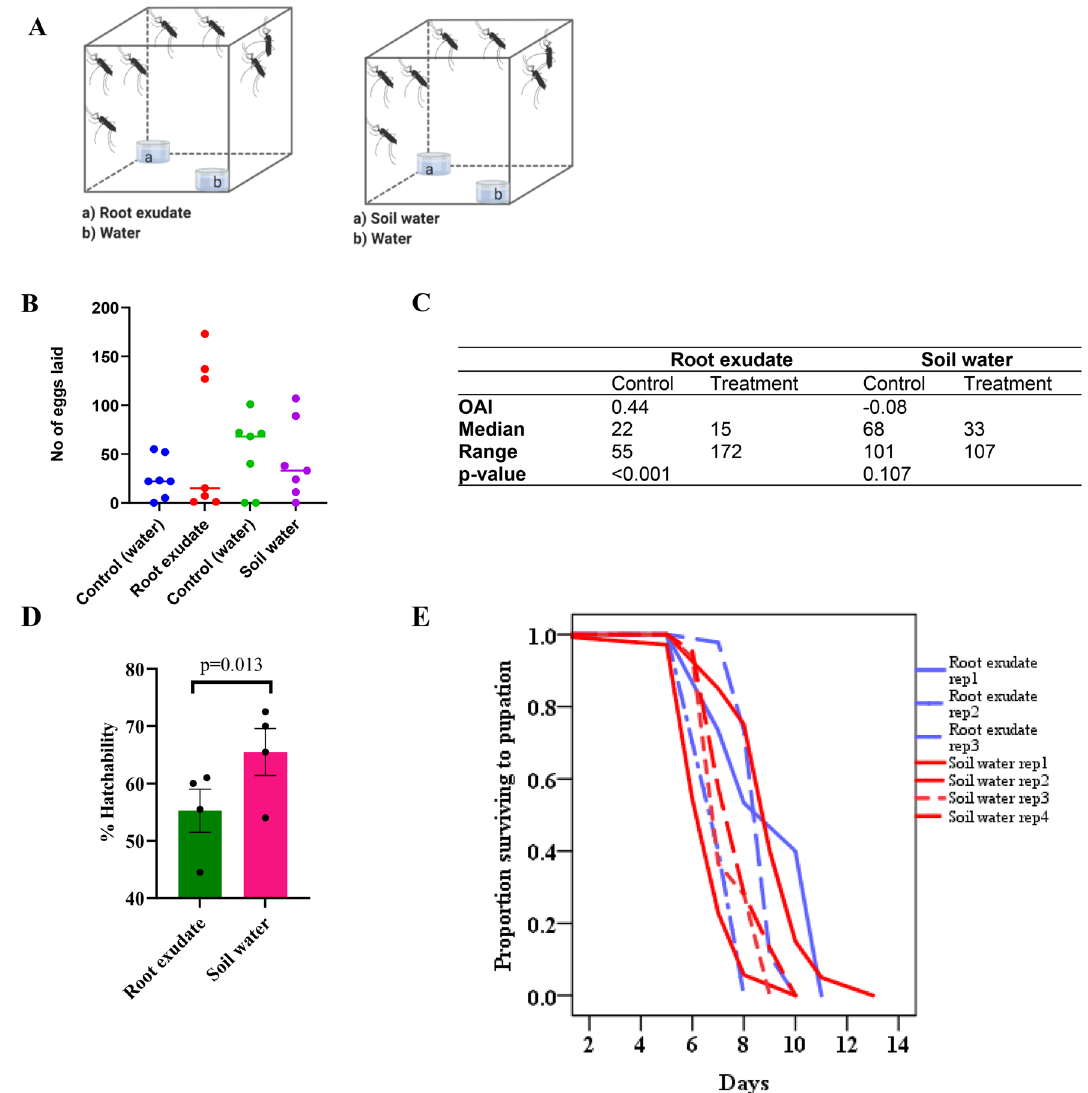
Figure 1. Effect of root exudate water on oviposition response and aquatic stage development of An. gambiae. ( A ) A schematic representation showing the setup of the oviposition experiment using root exudate water and soil water. ( B ) Oviposition activity of root exudate water and soil water. ( C ) Table summarizing median number of eggs laid and the range. ( D ) Egg hatch rates was low in root exudate water compared to soil water. ( E ) Time to pupation (days) for larvae exposed to root exudate water relative to soil